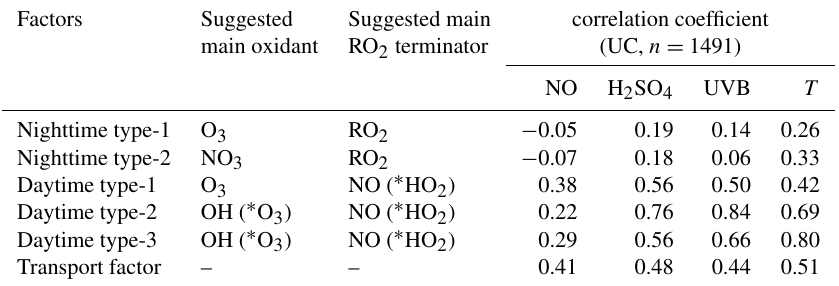
Table 2. Suggested HOM formation pathways represented by each factor and the uncentered correlation coefficients between factors and other relevant conditions. For each factor or relevant parameters, 1491 data points (30min time resolution) are used. ∗ These species cannot be ruled